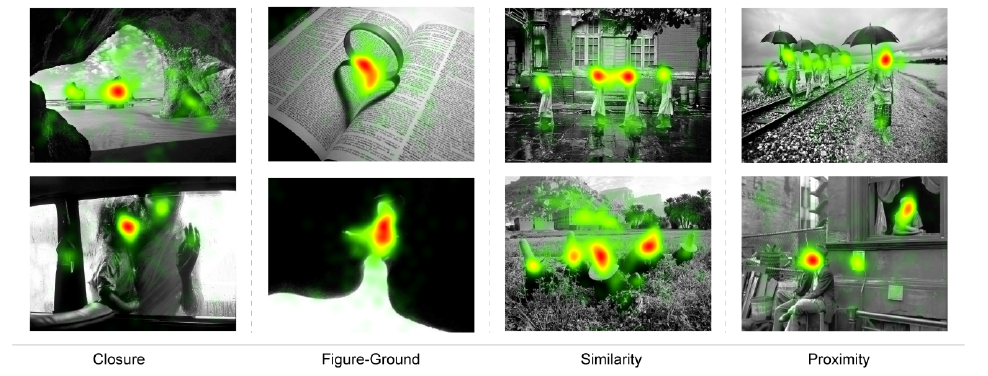
Figure 9. Heat map representation of gaze distribution